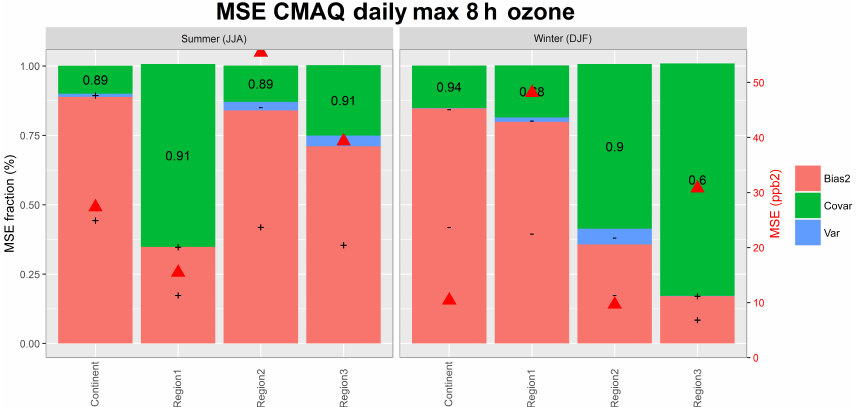
Figure 10. As in Fig. 6 for the rolling average daily maximum 8h ozone time